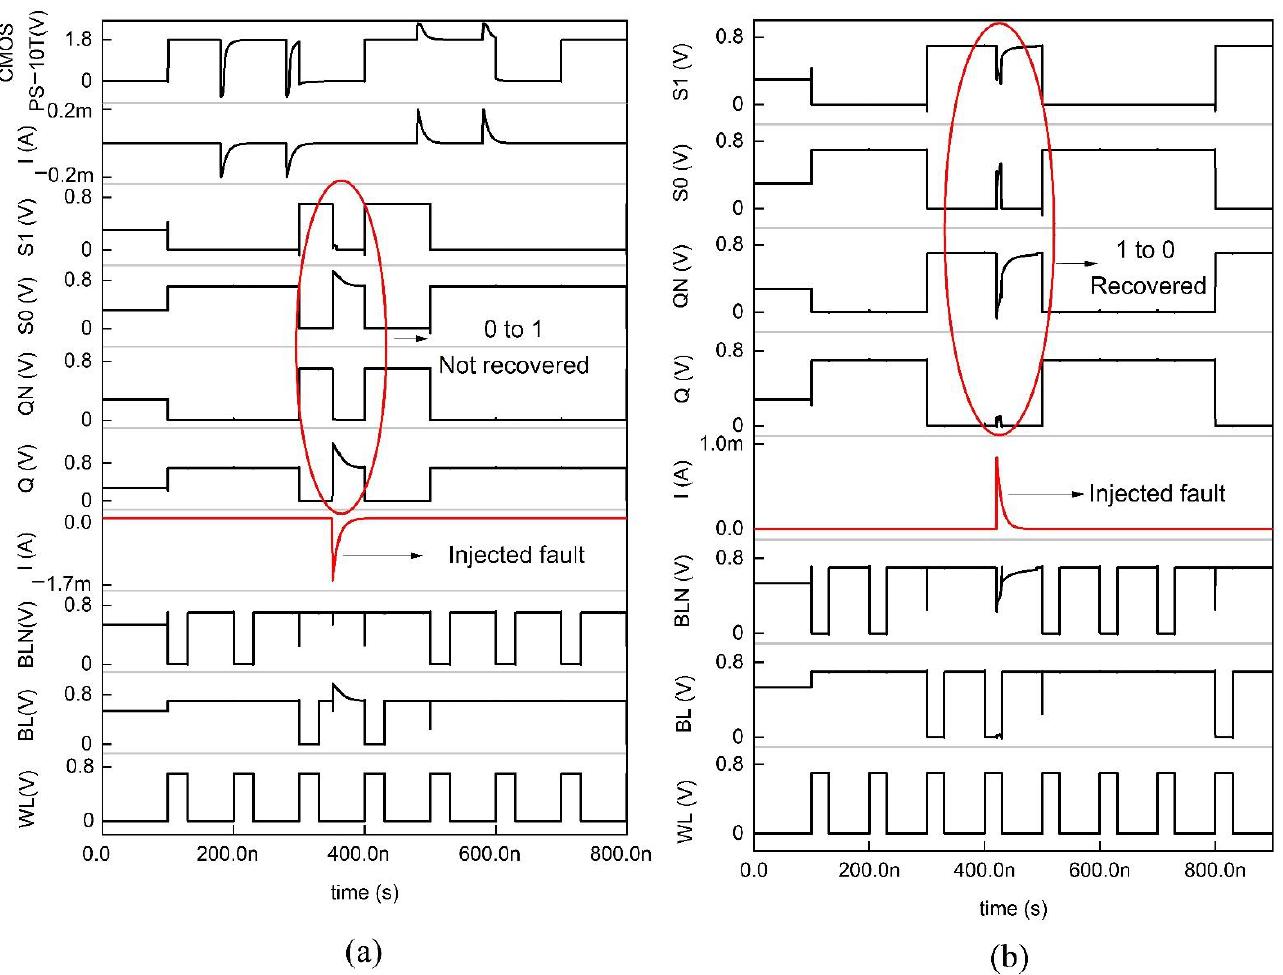
Figure 5. Schematic of the PMOS stacked 10T SRAM (PS-10T).